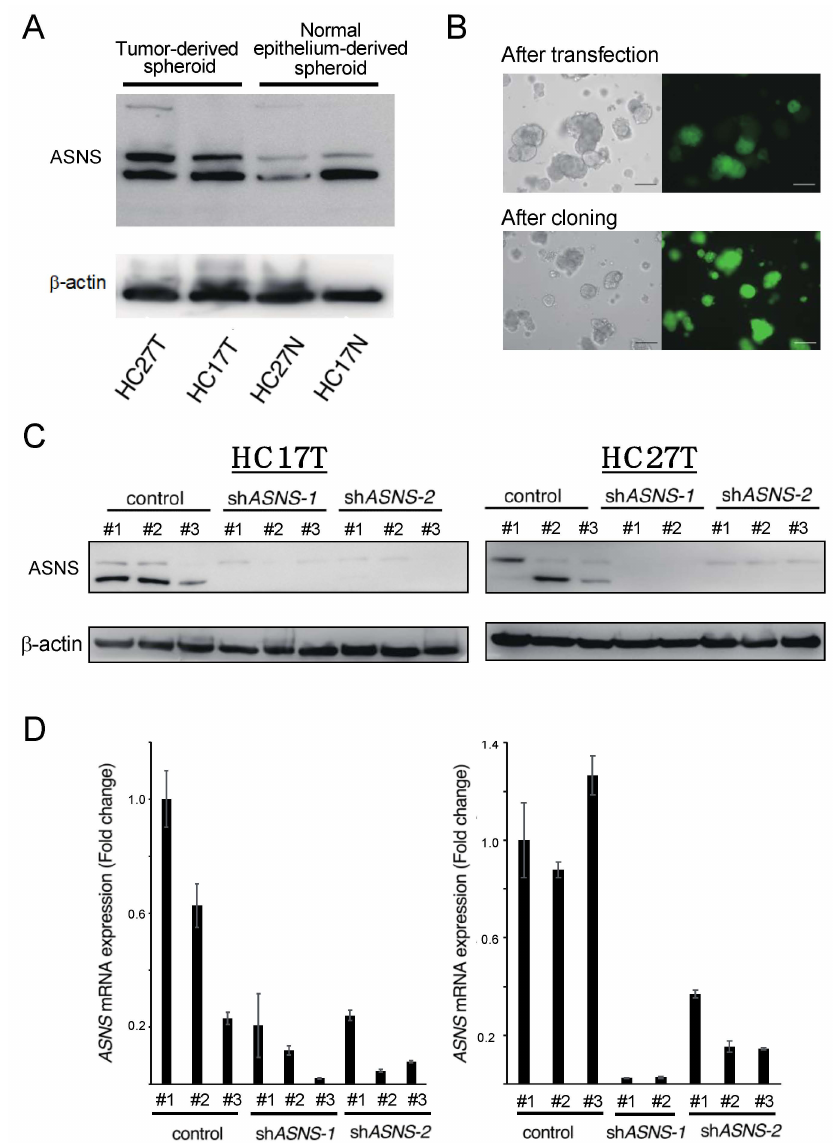
Figure 2. Construction of ASNS-knockdown spheroid clones. ( A ) Western blot analysis of ASNS expression. ( B ) GFP was used as a selection marker to confirm the transduction of shRNA con- struct into the spheroids. Scale bars, 100 µ m. ( C ) Western blot analysis of ASNS expression. Two spheroid lines, HC27T and HC17T, were treated with independent shRNA constructs targeting ASNS. ( D ) Quantitative RT-PCR showing relative mRNA levels for ASNS. The # in figure means each estab-lished